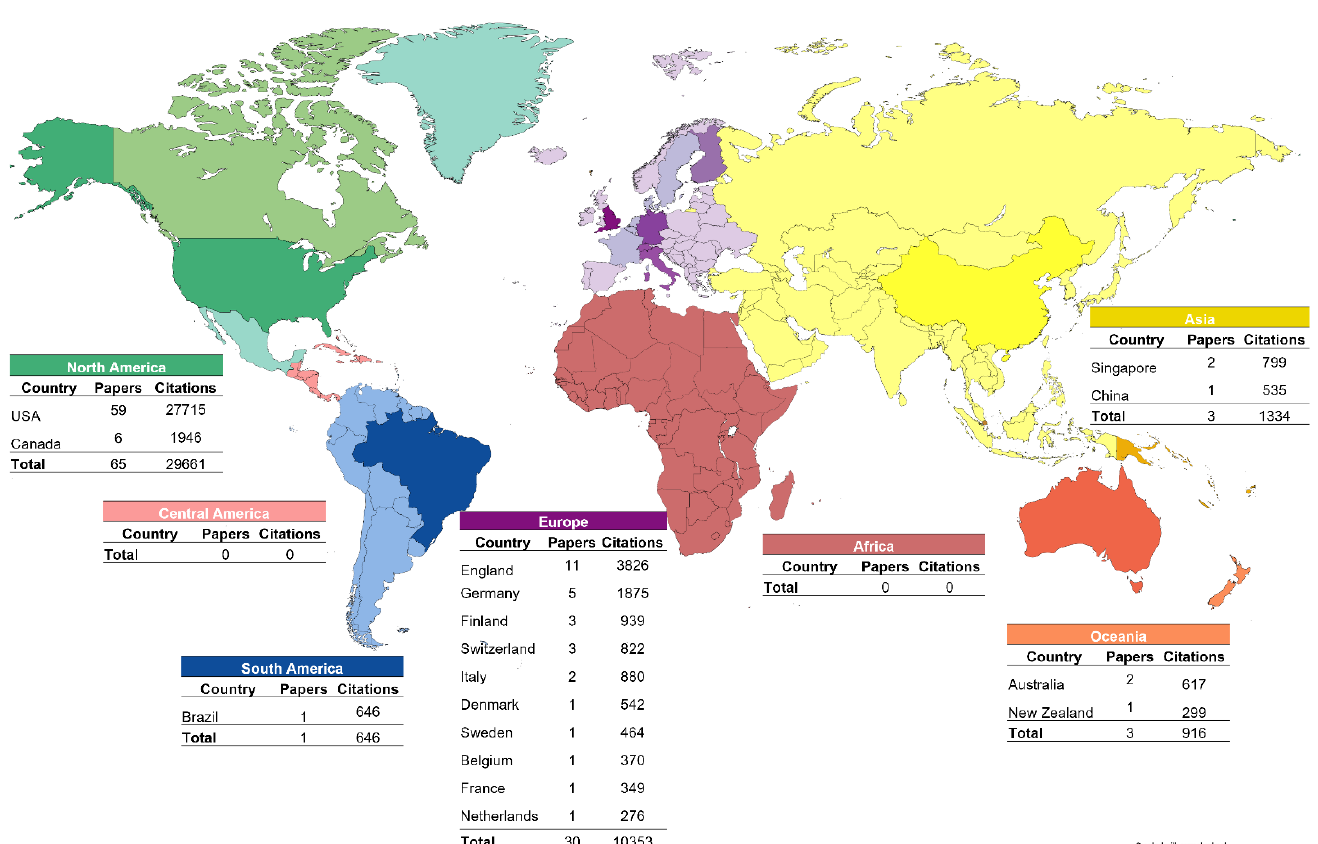
Figure 2. Distribution of the 100 most-cited articles about Midazolam by continents and countries. Mapchart created with mapchart.net and adapted by the authors.